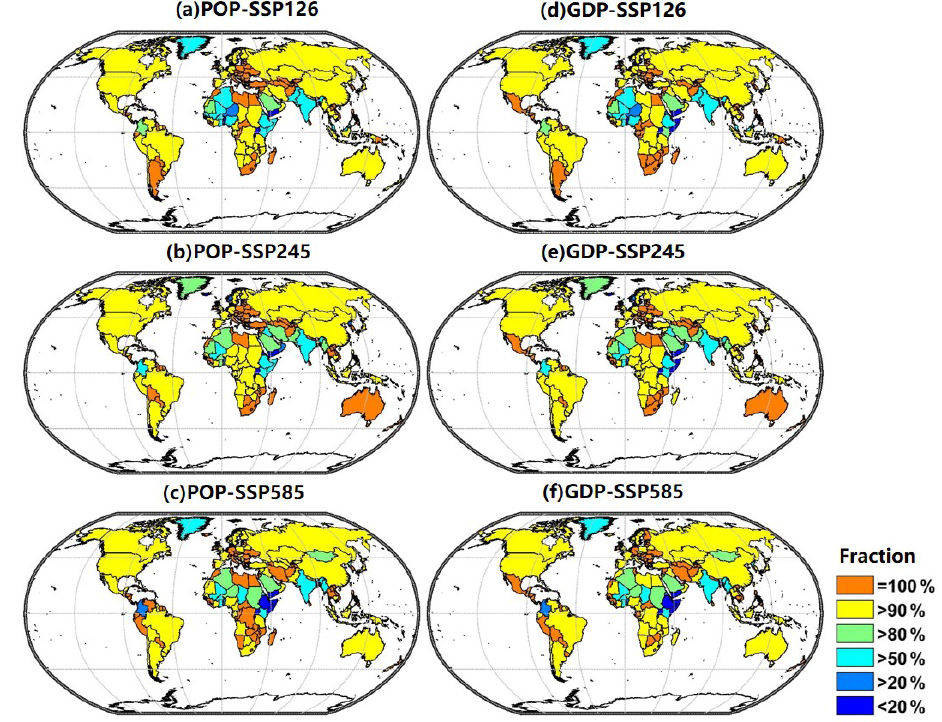
Figure 9. National population and GDP fraction exposure to more frequent severe droughts under the 1.5 ◦ C warming target.